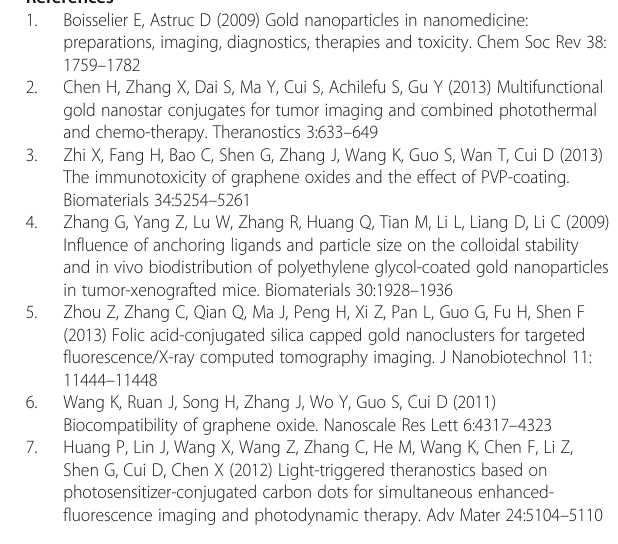
Additional file 1: Figure S1. Characterization of Fe 3 O 4 magnetic nanoparticles by HR-TEM. Figure S2. Characterization of Au clusters by HR-TEM. Scale bar, 5 nm. Figure S3. (A) TEM image of GNRs. Scale bar, 100 nm; (B) absorption spectra of GNRs. Figure S4. Distribution of Au nanoclusters in intestinal tissues. (A) Control groups; (B) ligation groups. Figure S5. Distribution of magnetic nanoparticles in goblet cells of mice with CBD ligation. Figure S6. Distribution of gold nanorods in goblet cells of mice with CBD ligation. Figure S7. Quantitative analysis of nanoparti- cles in feces based on ICP-MS. (DOCX 2987 kb) Abbreviations CBD: Common bile duct; CCD: Charge-coupled device; GCs: Goblet cells; GNRs: Gold nanorods; HBS: Hepato-biliary; PCs: Parietal cells;